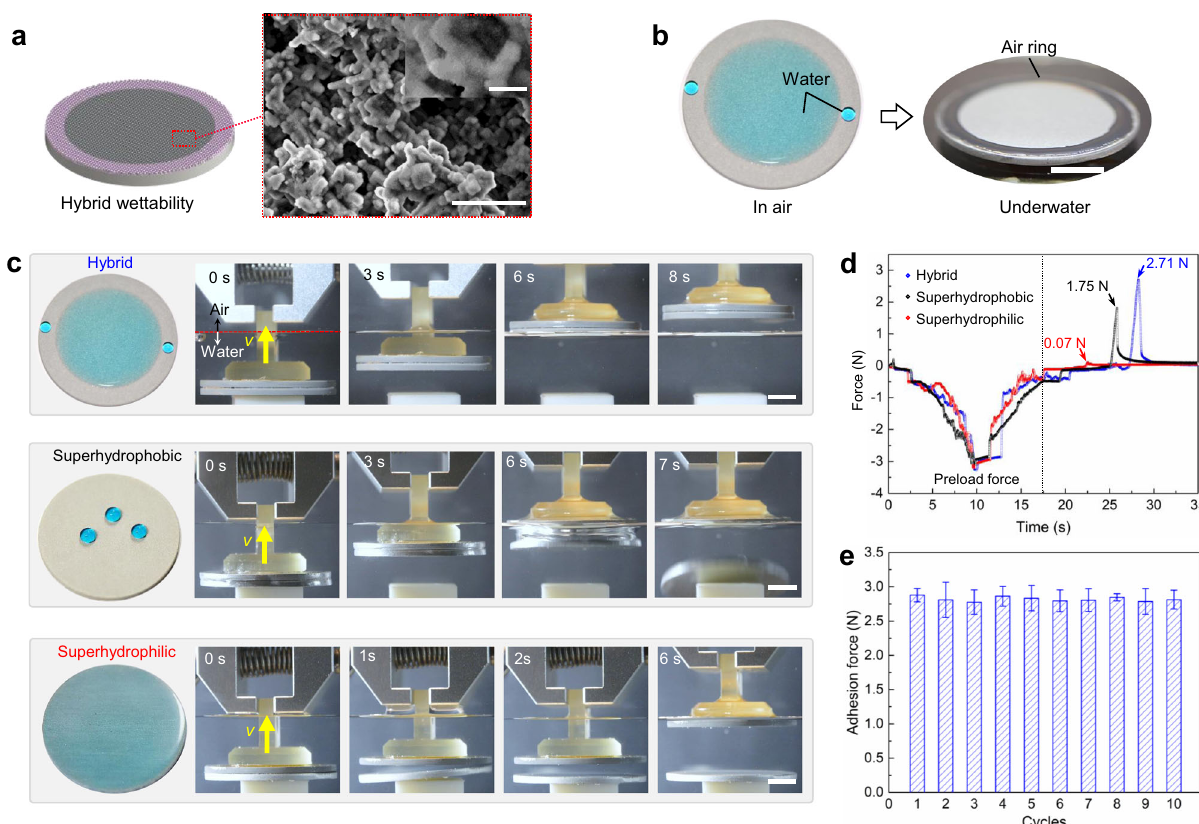
Fig. 2|Characterizationofunderwatercapillaryadhesion.a Schematicdrawing andthescanningelectronmicroscopic(SEM)imagesofthedual-scalestructuredAl plate with hybrid wettability. The scale bars in the SEM images are both 10 μ m. b Optical photos of Al plate with hybrid wettability in air and underwater. When beingimmersedinwater,theoutersuperhydrophobicregionofthehybridAlplate is screened by the uniform air ring, while the inner superhydrophilic region is completely wetted by water. The scale bar is 1cm. c Selected snapshot images